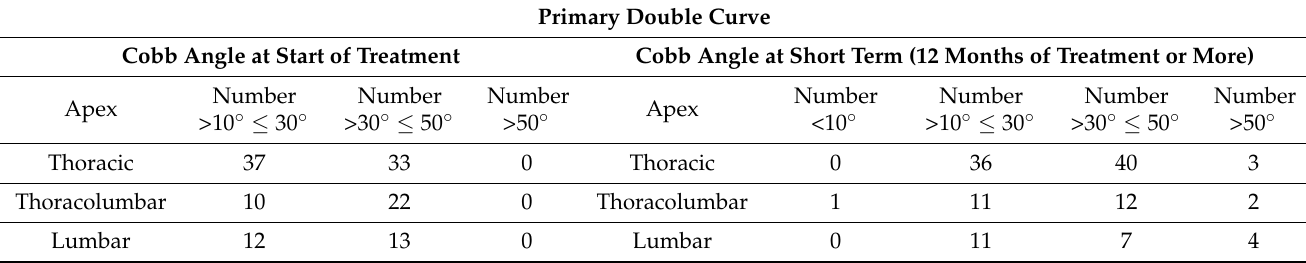
Table 5. Cobb angle changes for single